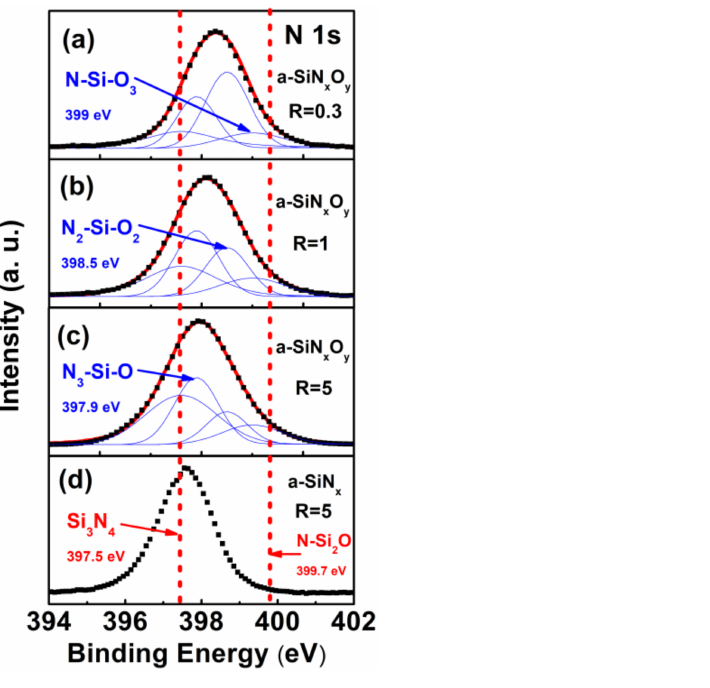
Figure 3. XPS spectra of N 1s of both a-SiN x O y with ( a ) R = 0.3; ( b ) R = 1; ( c ) R = 5, and the controlled a-SiN x films with ( d ) R = 5, which was measured after Ar ion beam sputtering at 90 nm depth. For a-SiN x O y films with different R, the Voigt peak fitting results are also shown as a solid